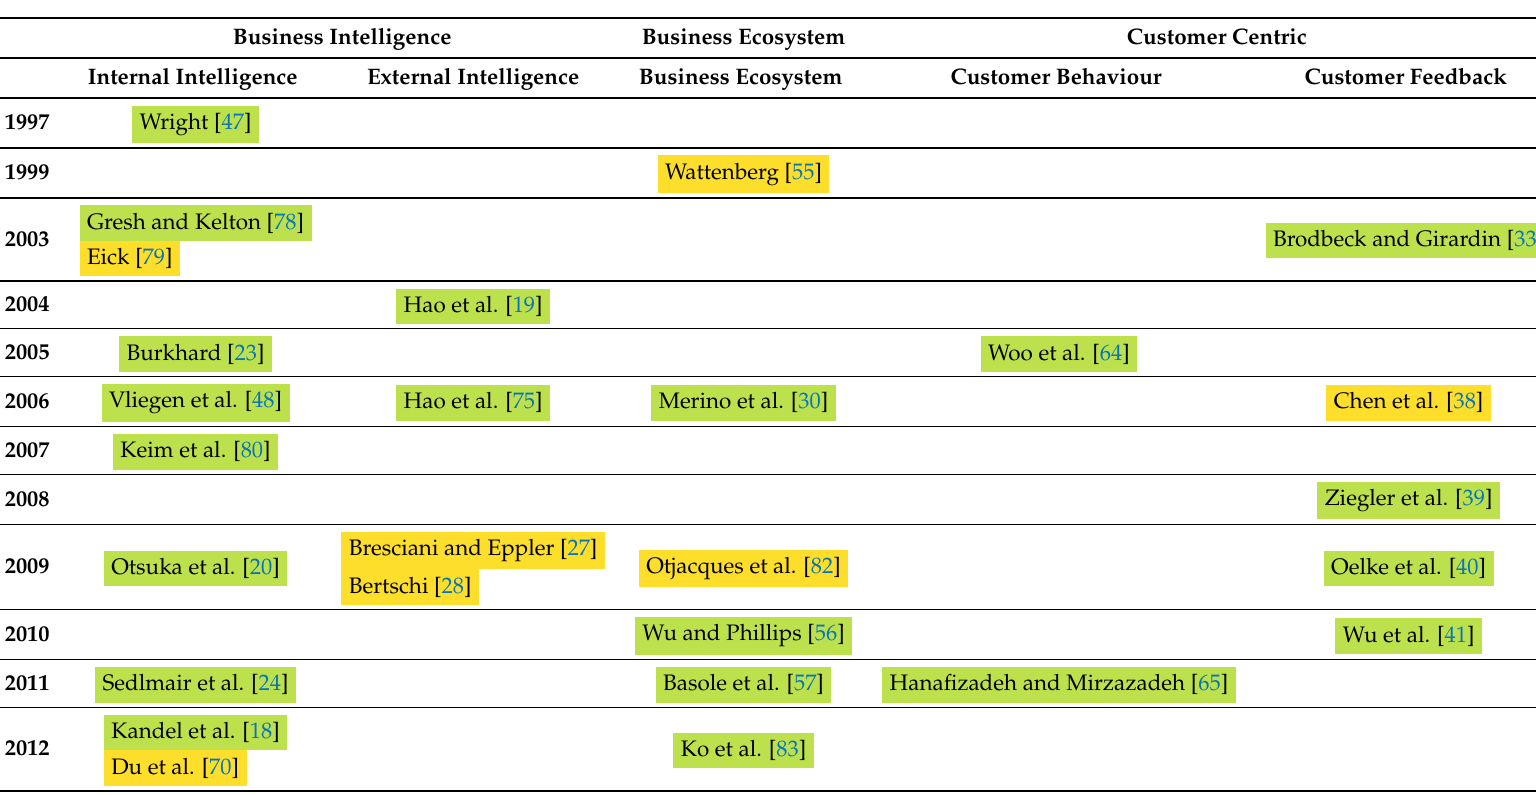
Table 5. This table shows a temporal classification of the papers included in the survey by year. Primary papers included in the survey are labelled in green and secondary papers are labelled in yellow . See Section 1.5 for a description of our primary and secondary papers. The secondary classification used in the survey is shown in Table